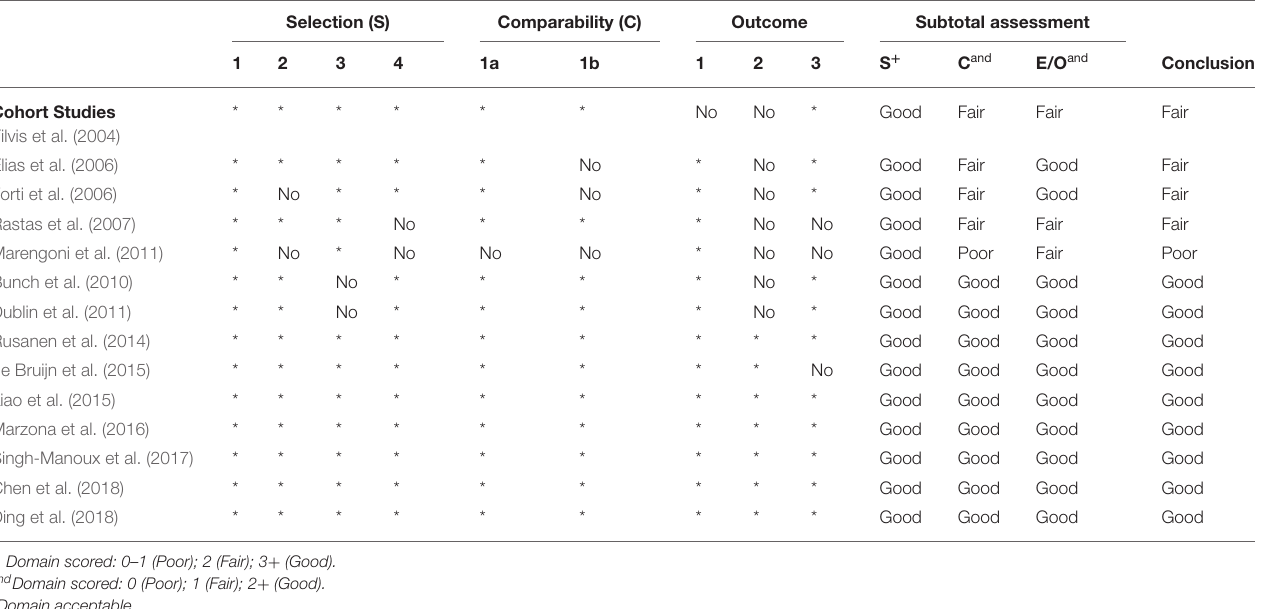
TABLE 2 | Quality assessment using the Newcastle Ottawa Scale.